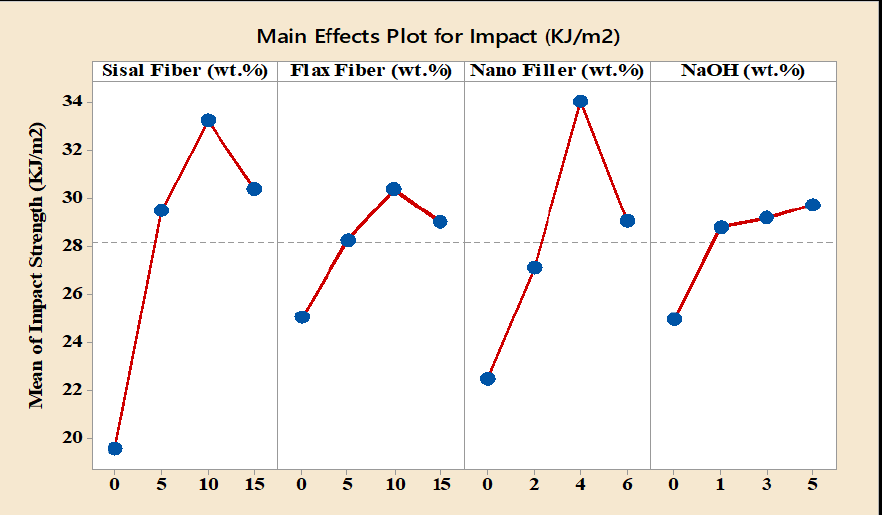
Figure 13. Mean Values of Impact Behaviour of Hybrid Composites with various input parame- ters.